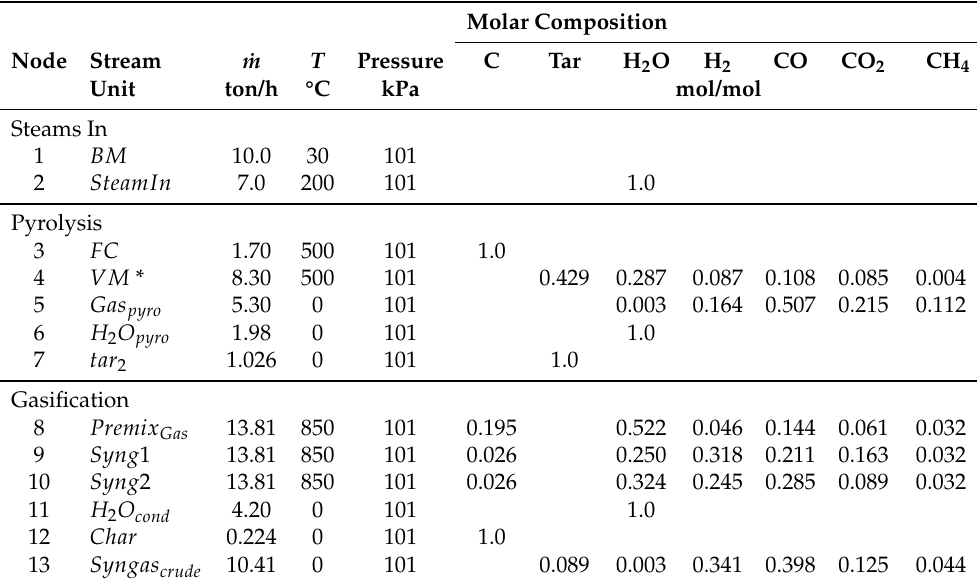
Figure 2. Mass flows ( ˙ m i ) are presented for the case study of a gasifier having a biomass (daf) consumption of 10 ton/h. Table 5. Material balance and composition for the model StoicM at a temperature of 850 °C and S / B of 0.7. * The molar composition of VM corresponds to the products of the pyrolysis reaction after R 2.